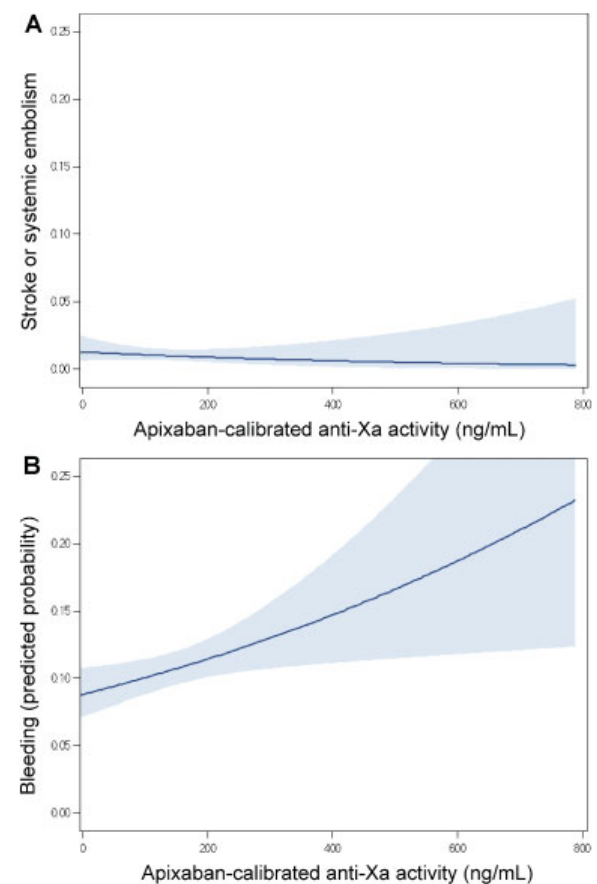
Fig. 2 Stroke/systemic embolism and bleeding versus anti-Xa activity. Predicted probability of ( A ) stroke/systemic embolism; or ( B ) bleeding of any severity (minor, clinically relevant nonmajor, or major) versus anti-Xa activity. The shaded region represents the 95% con fi dence